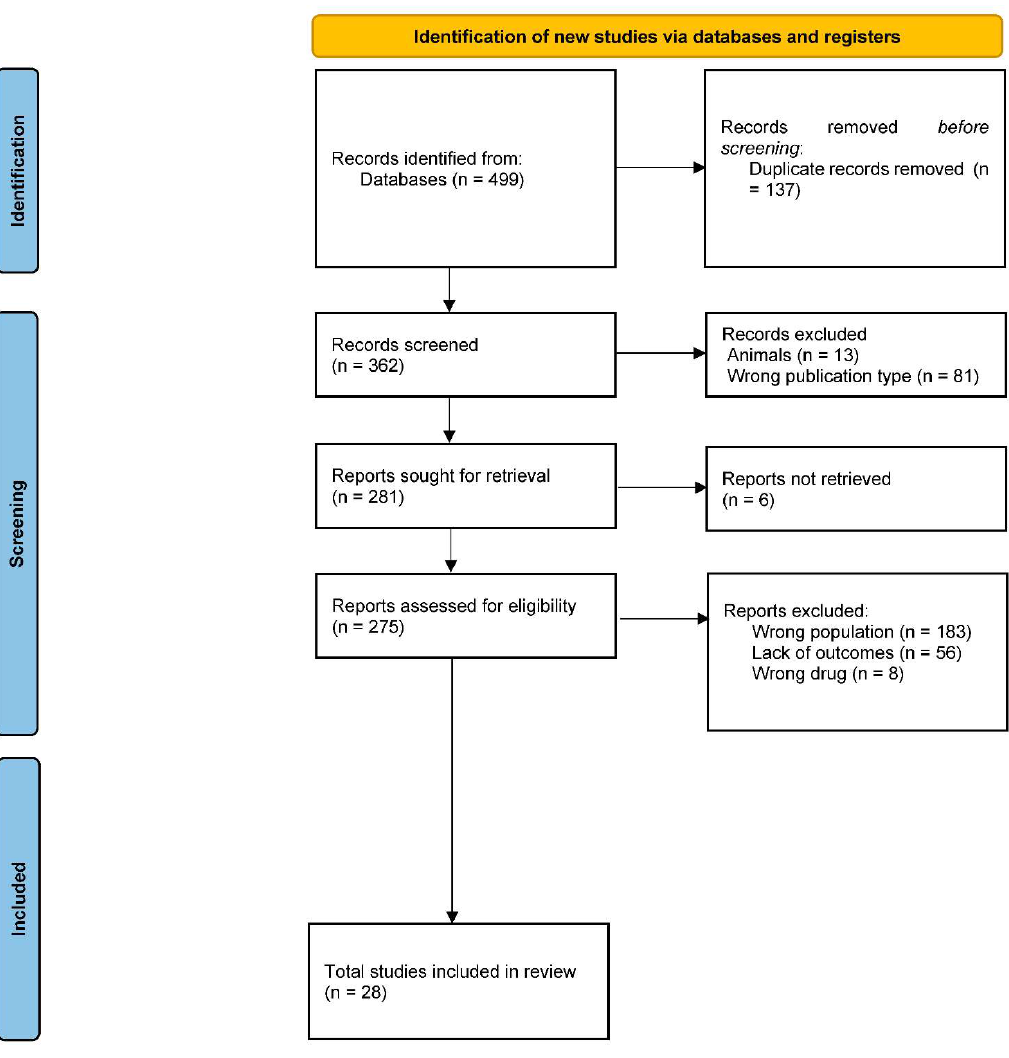
Figure 1 . PRISMA